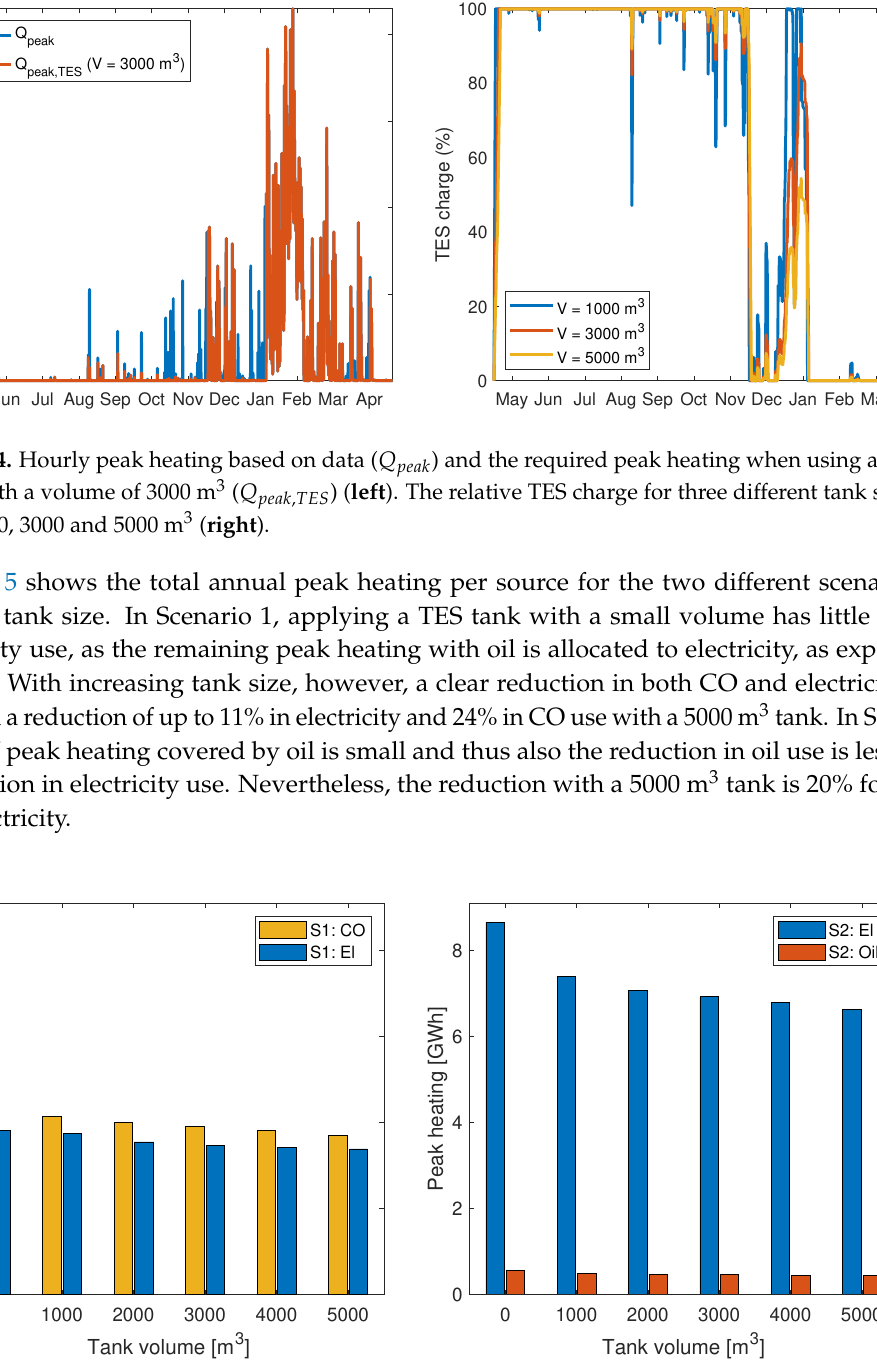
Figure 5. Total annual peak heating per source as a function of tank size for Scenario 1 ( left ) and Scenario 2 ( right